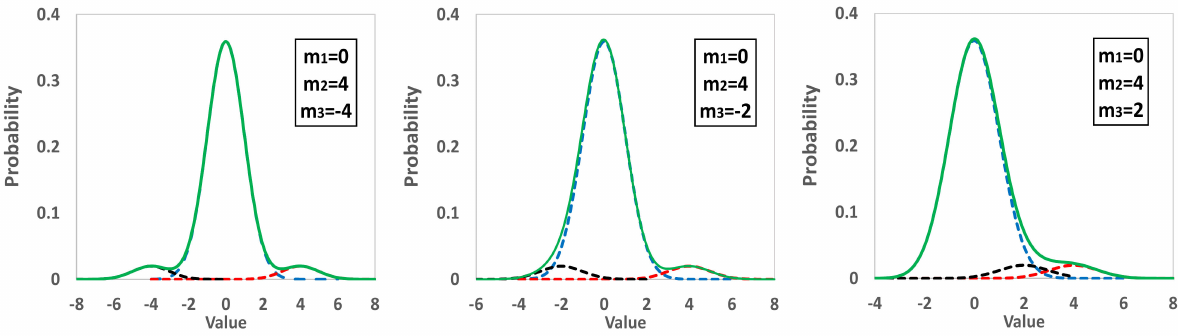
Figure 4. Distribution of populations consisting of a main and two secondary distribution. Dashed lines; main and secondary groups, and solid line; total